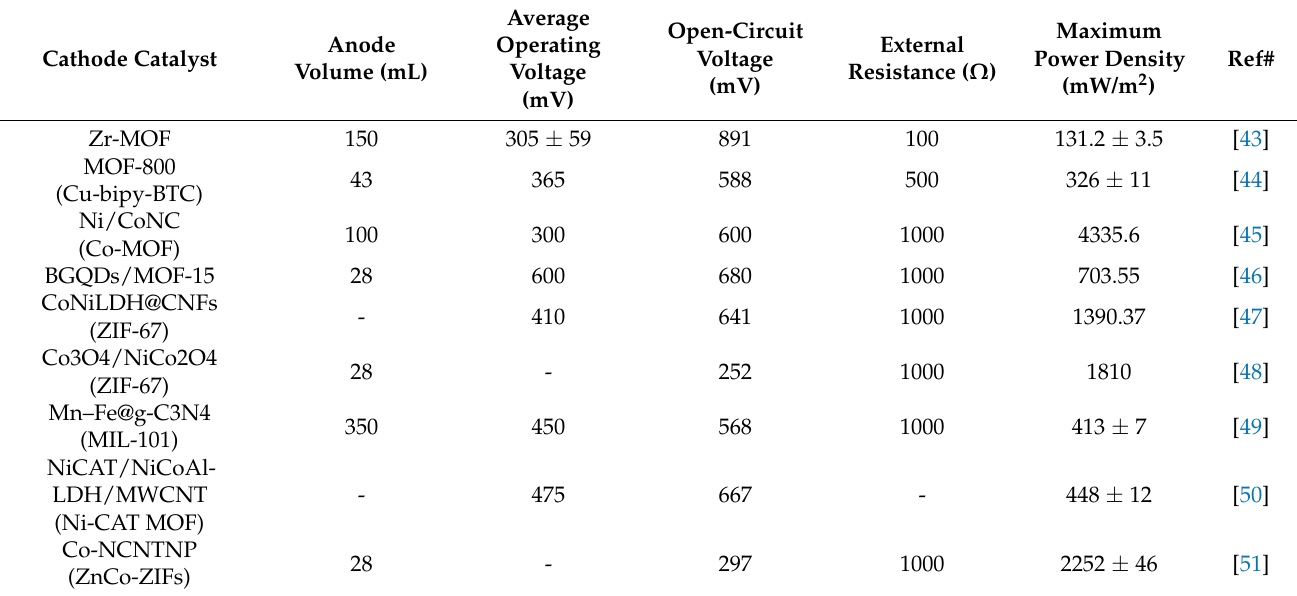
Table 1. MOFs used as MFC cathode materials and their